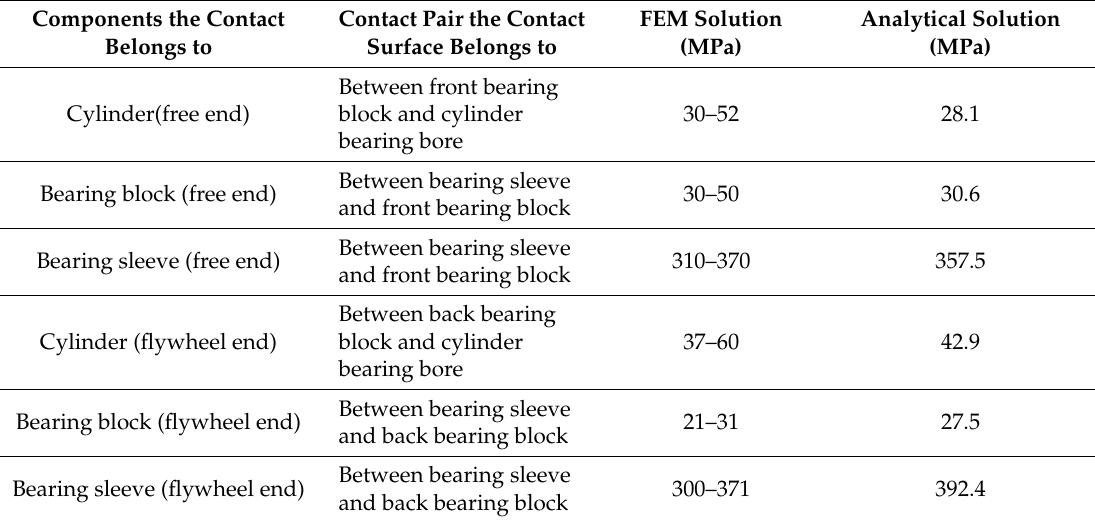
Table 6. Comparison of the von Mises stress on contact surface between analytical method and FEM. Components the Contact